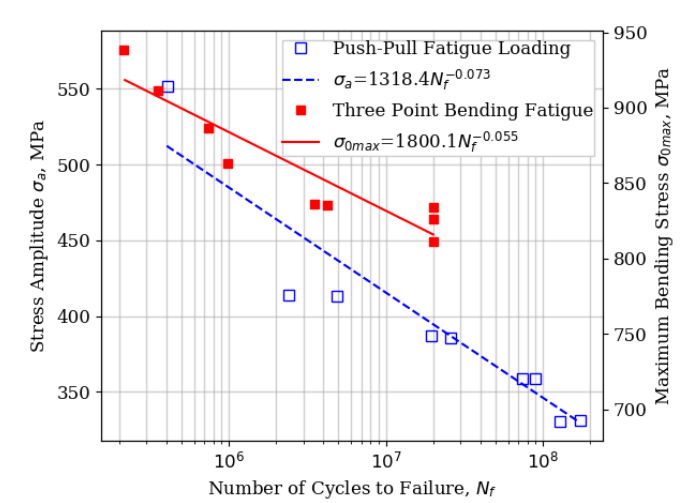
Figure 29: Comparison of effect of type of loading on wrought IN718, the S-N curves of push pull fatigue tests and three-point bending test and its comparison [72].